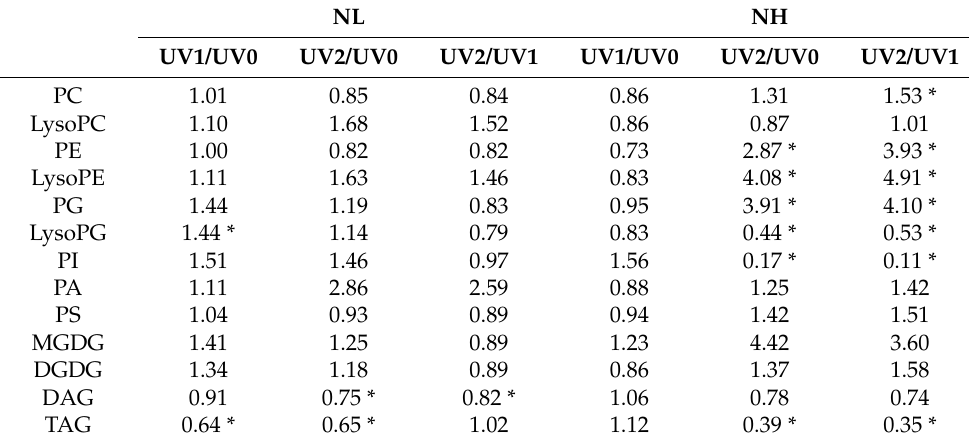
Table 1. Fold change of lipid content in tea leaves under different UV-B treatments under high/low nitrogen levels (NH/NL). The ‘*’ indicates a significant difference ( p <